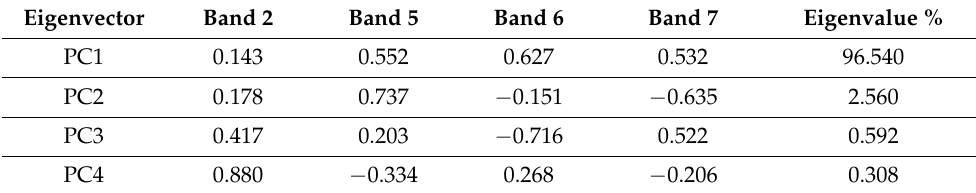
Table 1. PCA analysis of selected Landsat-8 OLI bands.